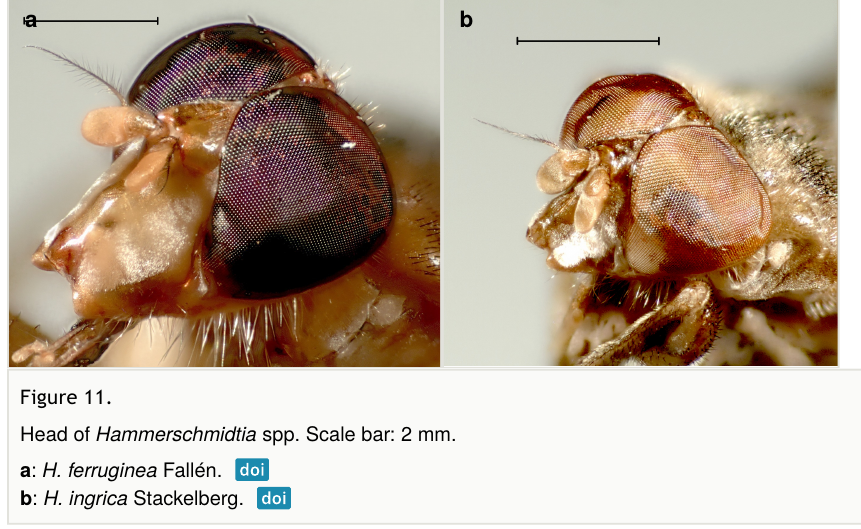
Figure 11. Head of Hammerschmidtia spp. Scale bar: 2 mm. a : H. ferruginea Fallén. b : H. ingrica